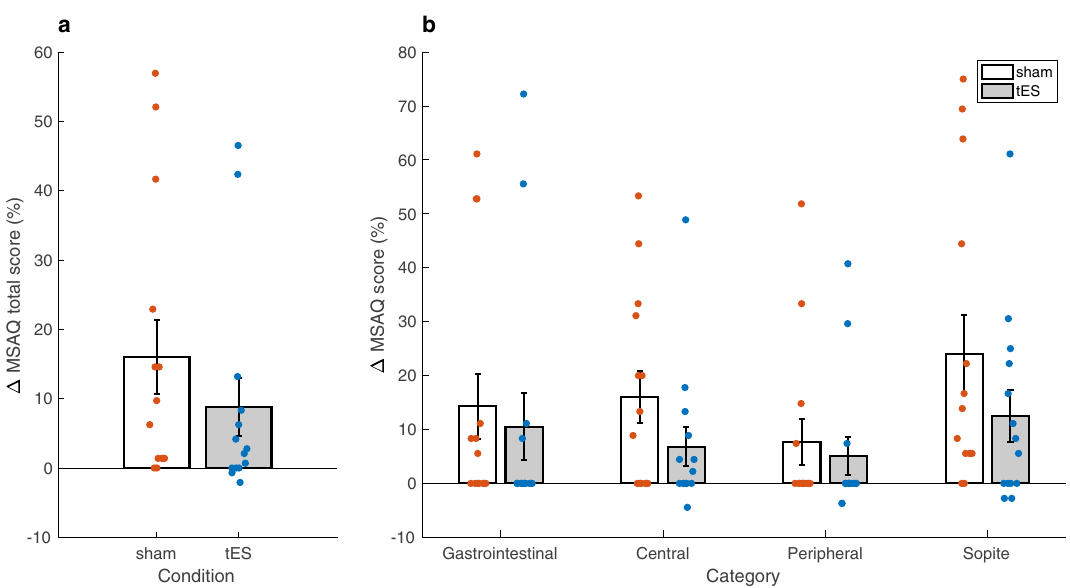
Figure 4. Summary of motion sickness assessment questionnaire (MSAQ) total and subscale scores across participants. (a) Average change in MSAQ total scores between sham and tES condition. (b) Average change in MSAQ scores within each category (gastrointestinal, central, peripheral, sopite) between sham and tES condition. Data are shown as mean ±